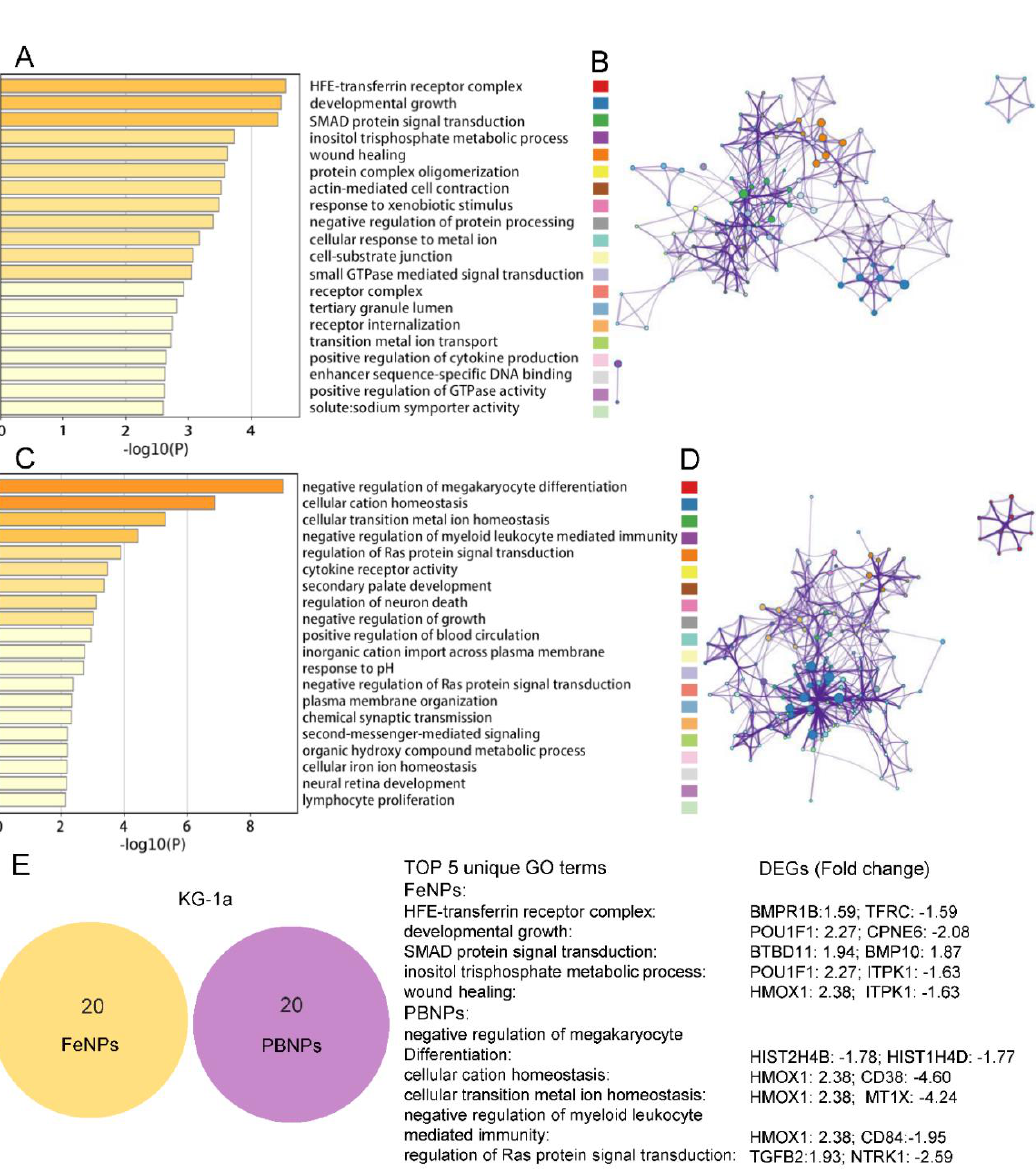
Figure 5. Top 20 GO terms of the KG1a cells treated with two kinds of iron nanoparticles: ( A , B ) heatmap ( A ) and enrichment network ( B ) colored by the same cluster of GO terms in the FeNP-treated KG1a cells, and ( C , D ) heatmap ( C ) and enrichment network ( D ) colored by the same cluster of GO terms in the PBNP-treated KG1a cells. The colored labels followed the order of top 20 GO terms. ( E ) Venn analysis of top 20 GO terms in the KG1a cells treated with PBNPs and FeNPs. The detailed information of all GO terms is shown in File S2 (Supplementary Materials). Table 2. GO terms of metal ion metabolisms in KG1a and HL60 exposed to FeNPs or PBNPs (Top 20, p < 0.01).